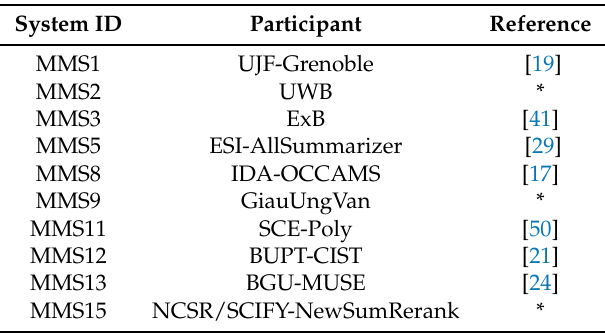
Table 3. Systems that participated at MultiLing 2015 (MMS